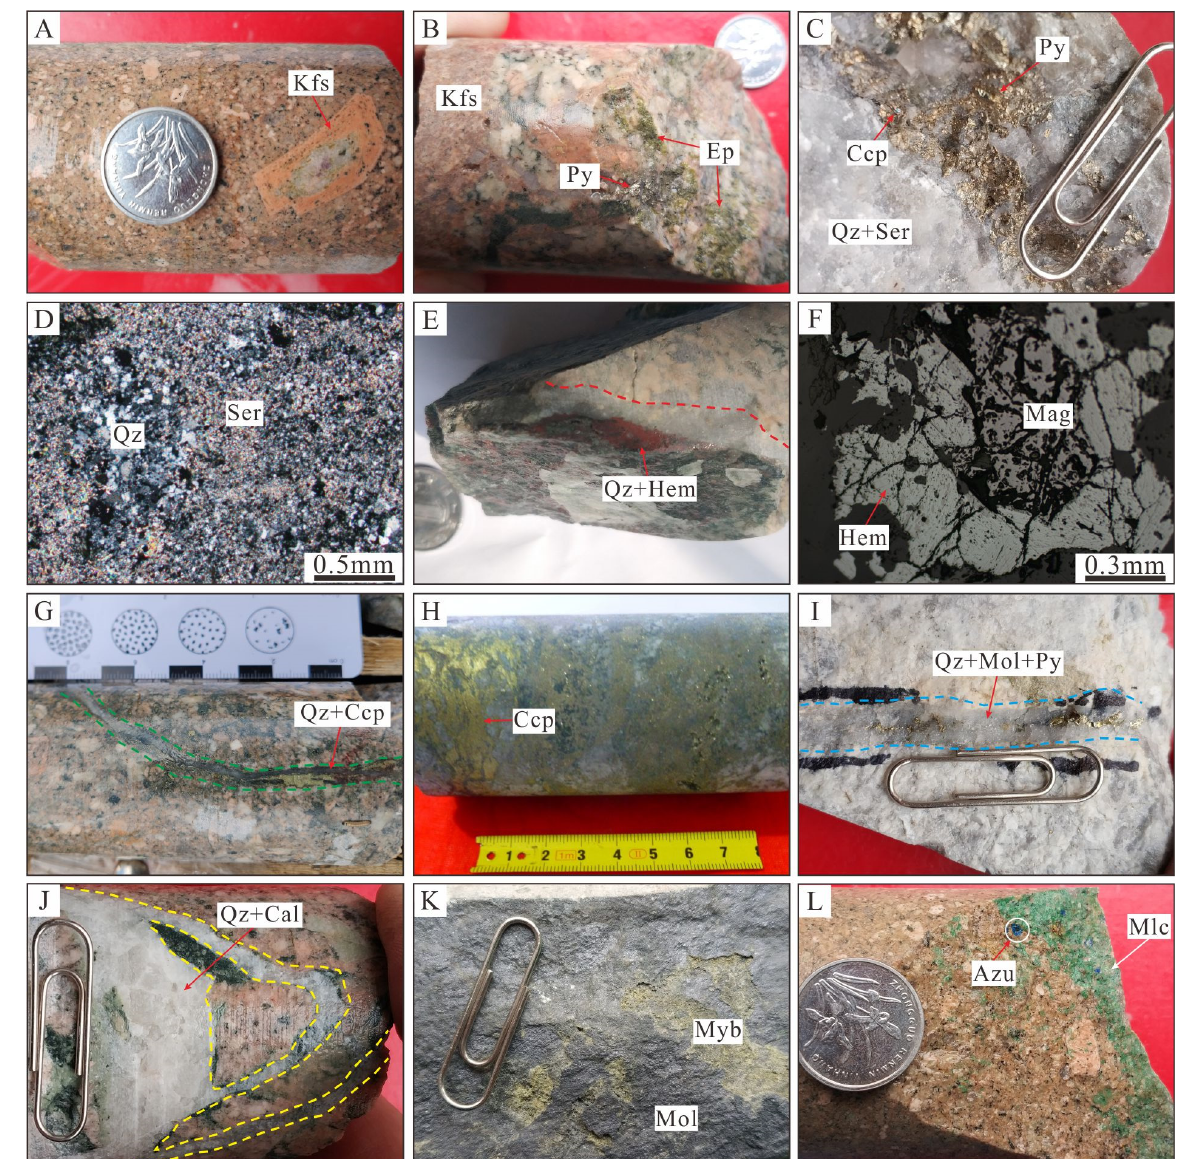
Figure 3. Photographs and photomicrographs of representative hydrothermal alterations and ore mineralization features in the Huoluotai Cu (Mo) deposit. ( A ) Potassic alteration observed in the gra- nodiorite porphyry. ( B ) Potassic alteration overprinted by epidote alteration. ( C ) Phyllic alteration in the granodiorite porphyry. ( D ) Phyllic alteration characterized by an alteration assemblage of sericite and quartz. ( E ) Stage I quartz + hematite vein in potassic-altered granodiorite porphyry. ( F ) Anhedral hematite and magnetite in stage I. ( G ) Stage II quartz + chalcopyrite vein in potassic-altered granodior- ite porphyry. ( H ) Dense disseminated chalcopyrite developed in the granodiorite porphyry. ( I ) Stage III quartz + molybdenite + pyrite vein in phyllic-altered wall rock. ( J ) Stage IV quartz + calcite vein in potassic-altered granodiorite porphyry. ( K ) Primary molybdenite oxidized to molybdite. ( L ) Primary chalcopyrite oxidized to azurite and malachite. Abbreviations: Qz = quartz; Kfs = K- feldspar; Ep = epidote; Ser = sericite; Cal = calcite; Mag = magnetite; Hem = hematite; Py = pyrite; Ccp = chalcopyrite; Mol = molybdenite; Myb = molybdite; Mlc = malachite; Azu =